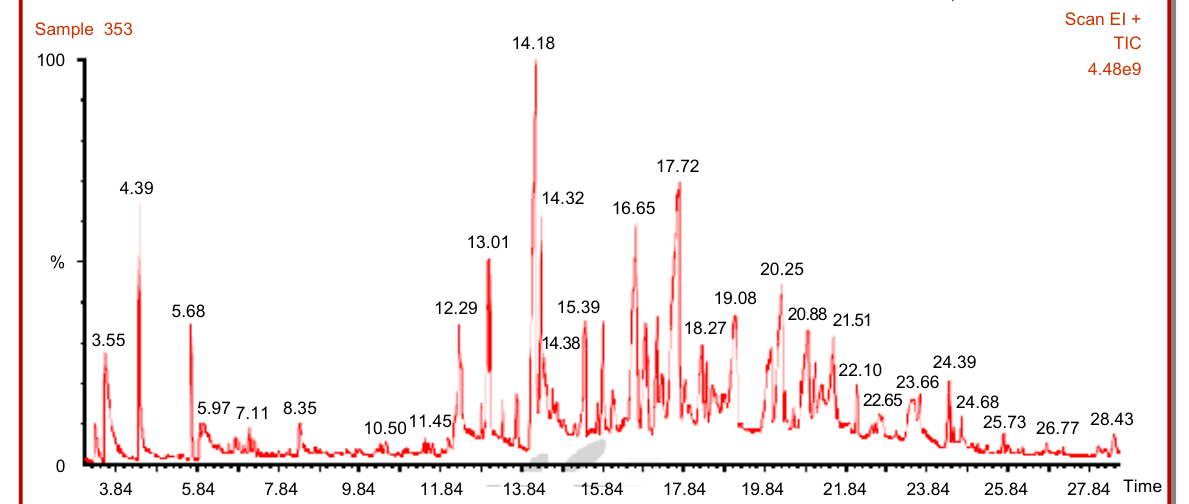
Figure 1: GC-MS analysis report for ethanol extract of Coleus forskohlii root